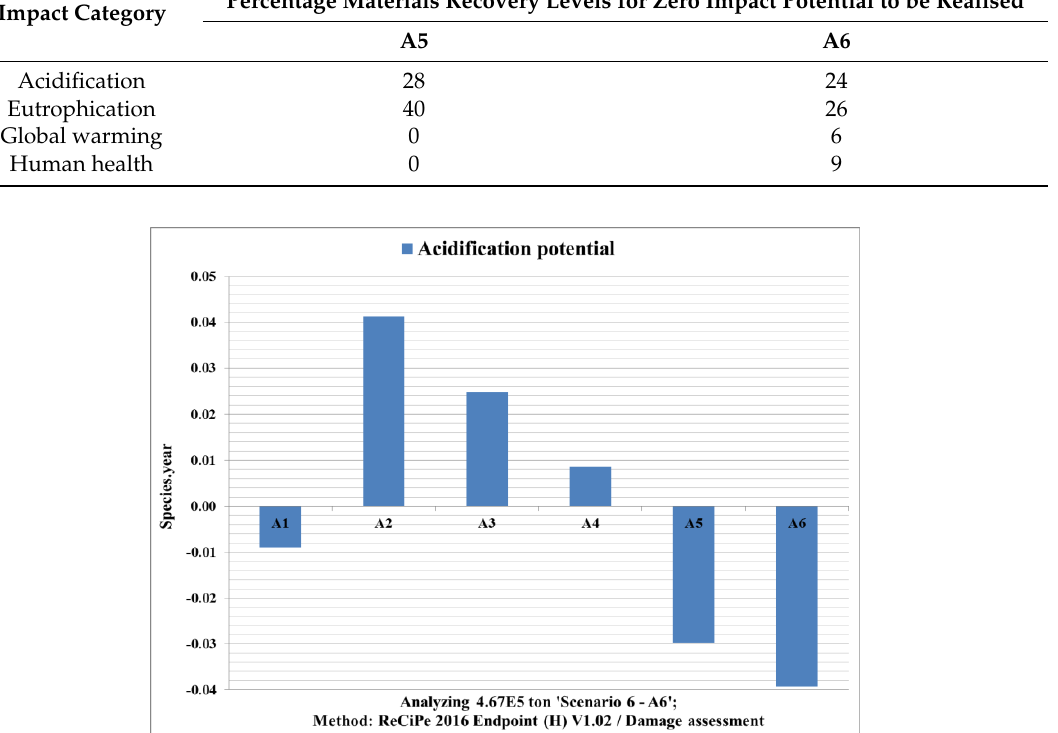
Table 5. Sensitivity analysis.